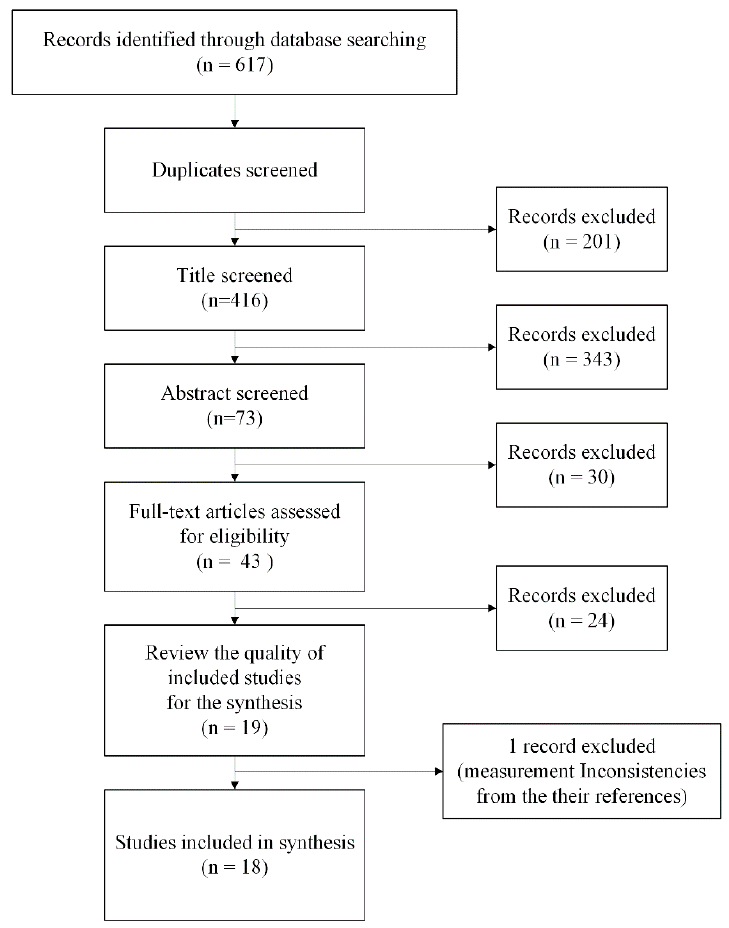
Figure 1. PRISMA diagram of this study (based on Moher et al. 2009).